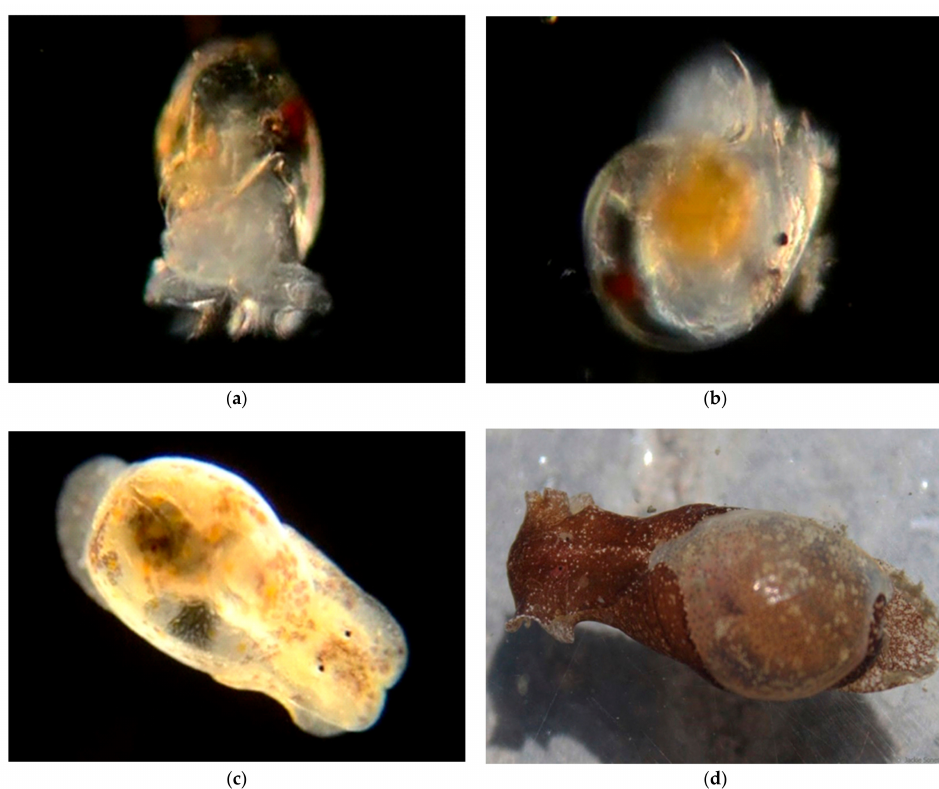
Figure 20. Family Haminoeidae . White Bubble snail, Haminoea vesicula . ( a ), Veliger CCDB-24722-G12 from off Newport Pier. ( b ) Veliger CCDB-24002-A06 from Balboa at Coral. ( c ) Juvenile BIOUG01205- H09 from Balboa at Coral. ( d ) Adult from Bodega Head, CA, photo courtesy of Jackie